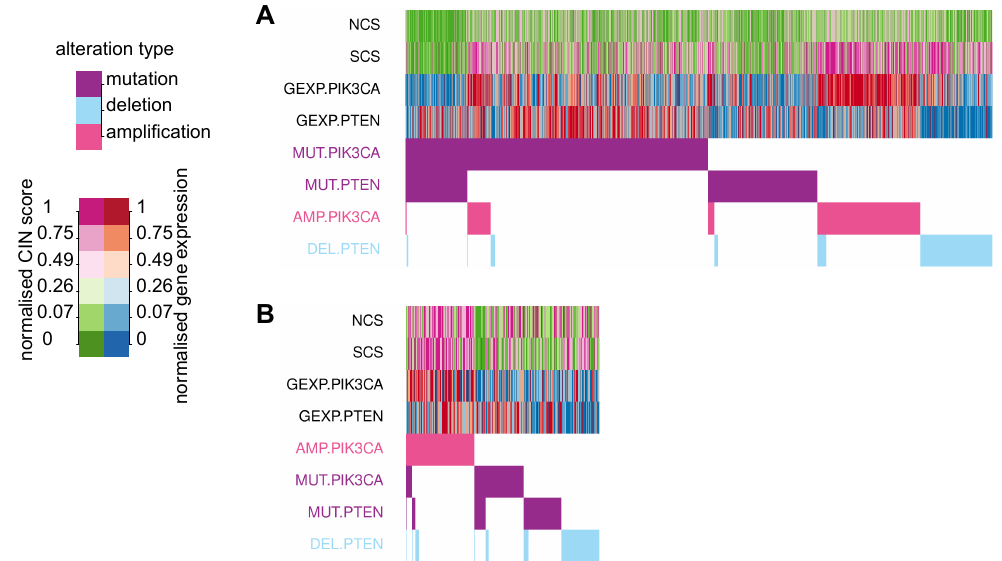
Figure 6. Oncoprint for PIK3CA and PTEN in relation to CIN. ( A ) The bottom panel depicts the presence or absence of somatic mutations, copy number amplifications of PIK3CA and deletions of PTEN in TCGA tumour samples (columns). Alterations are sorted by their frequency. The upper panel shows the NCS, SCS, PI3KCA and PTEN gene expression. Different levels of CIN scores and gene expression are encoded by colours. ( B ) The corresponding oncoprint for cell line data from